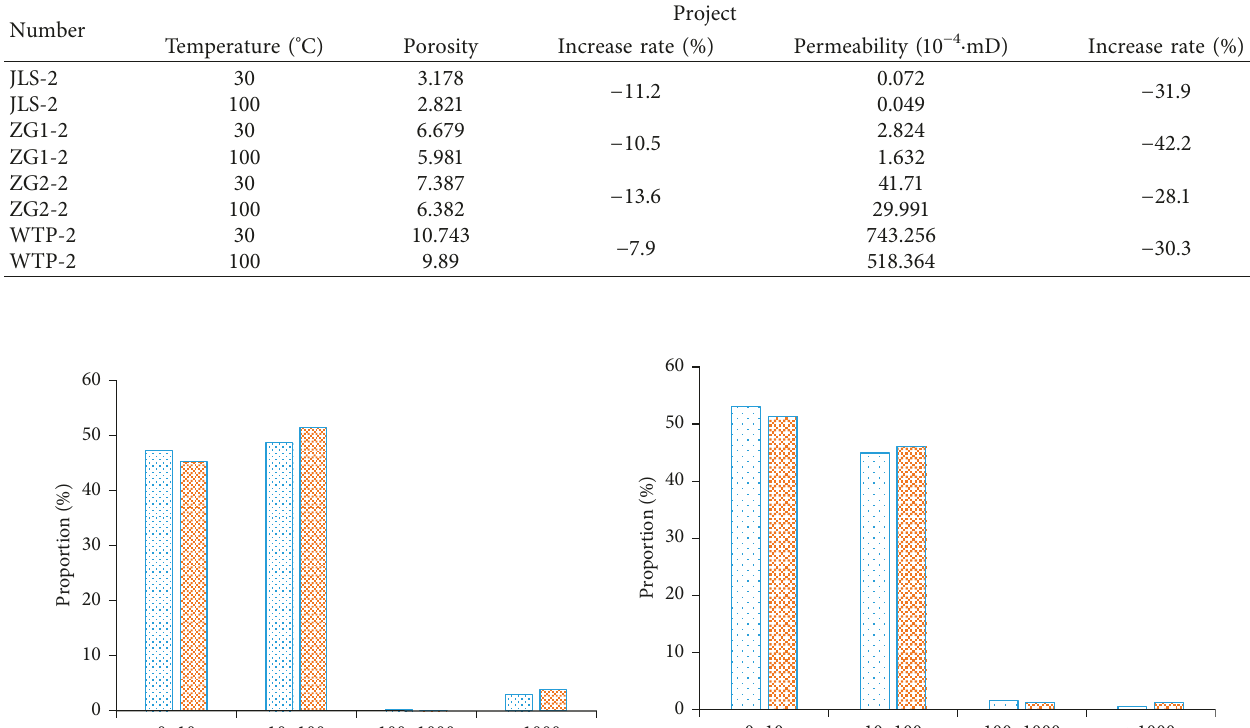
Table 3: Porosity and permeability of coal samples under high temperature.